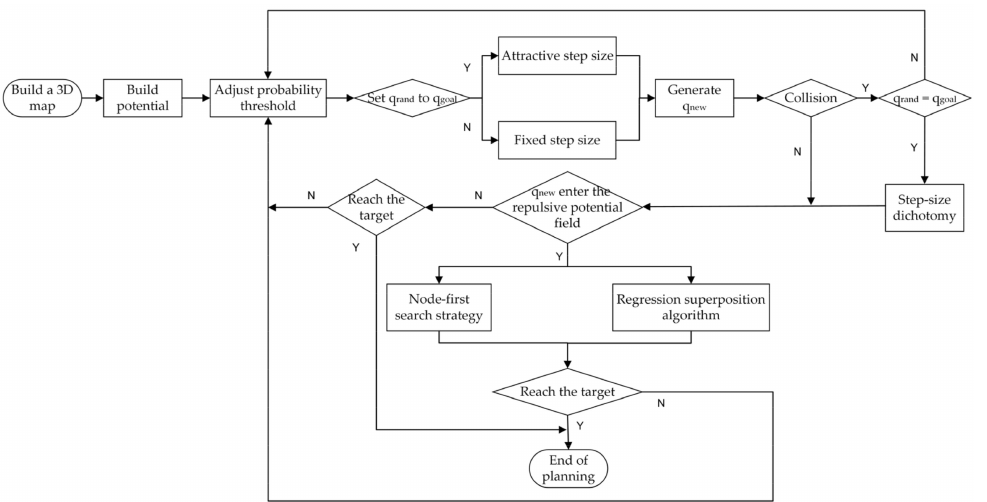
Figure 8. Flowchart of the TO-RRT algorithm. Note: A, yes; N,